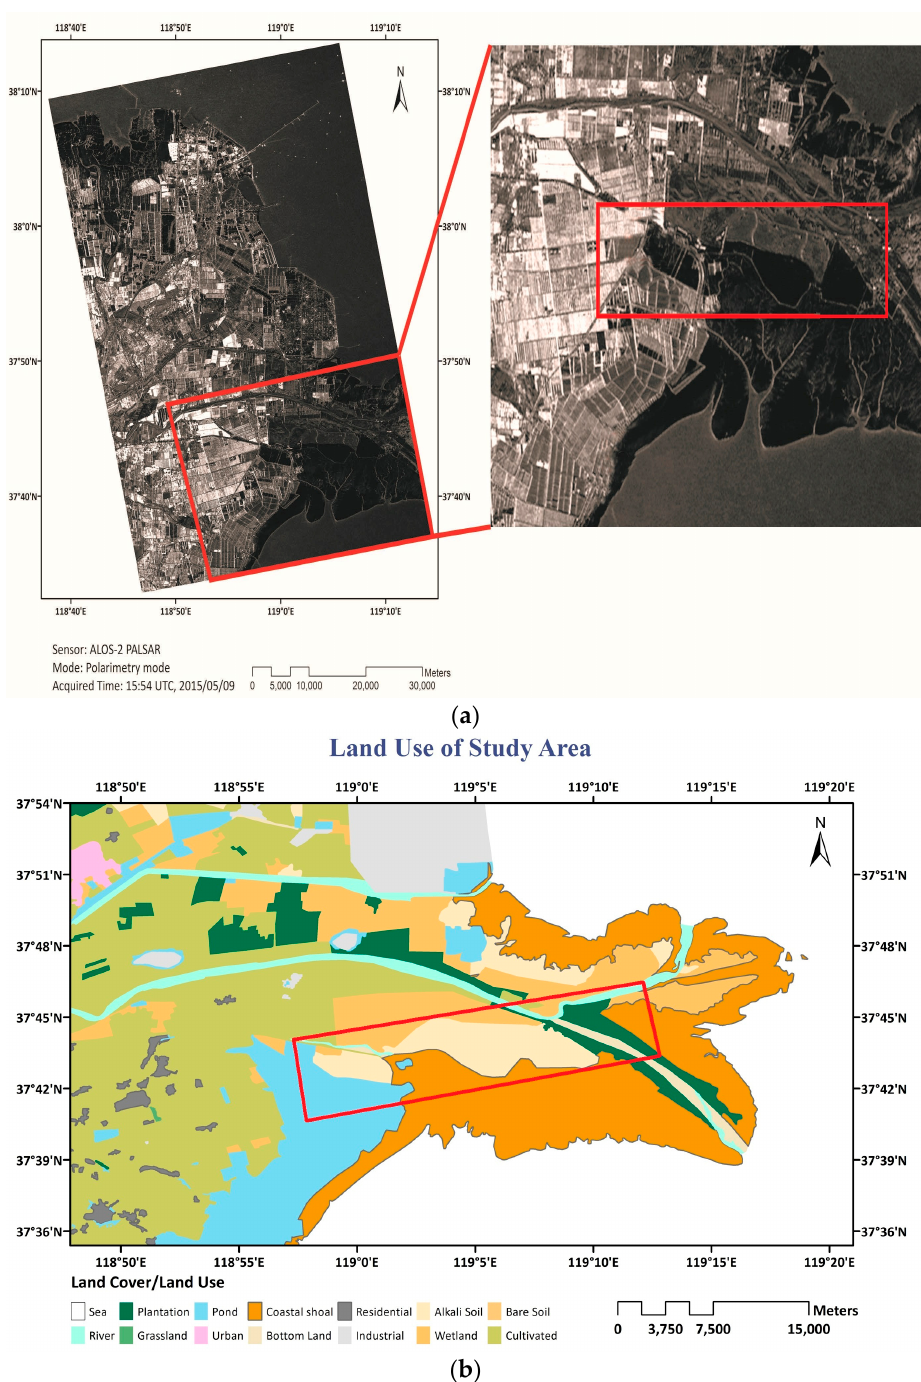
Figure 8. ( a ) Yellow River Delta dataset; ( b ) Official land use of study area generated for 2015.